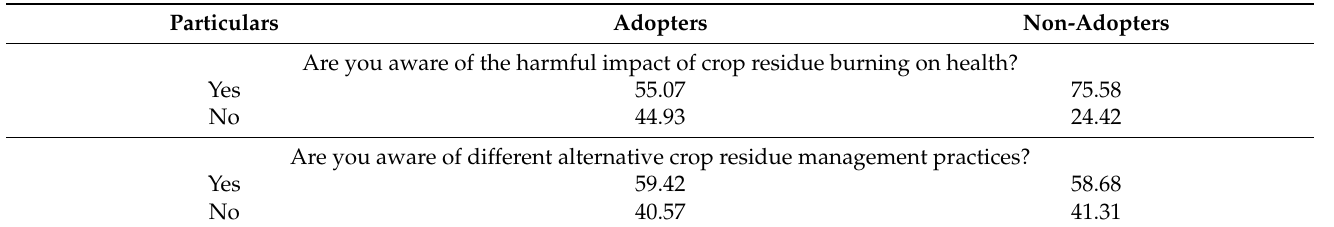
Table 6. Knowledge about the hazardous impact of crop residue burning (percentage).